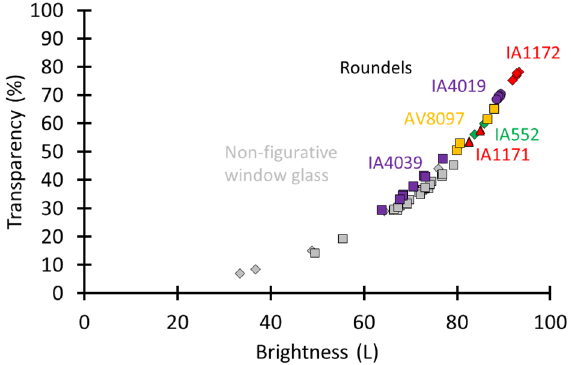
Figure 9. The brightness and transparency values show that more daylight was transmitted through a roundel compared with the non-figurative window glazing. The same legend code as in Fig. 7 was